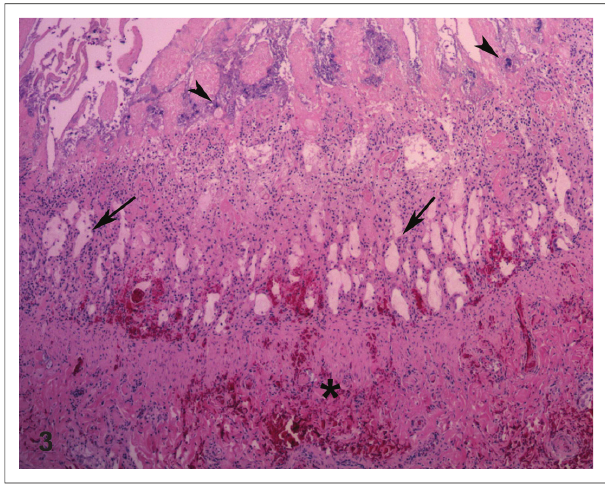
Source : Photo taken by Dr Peter Caldwell Note: the haemorrhagic nasal discharge. FIGURE 1: Feline panleukopaenia virus infection; cheetah, Case 8.